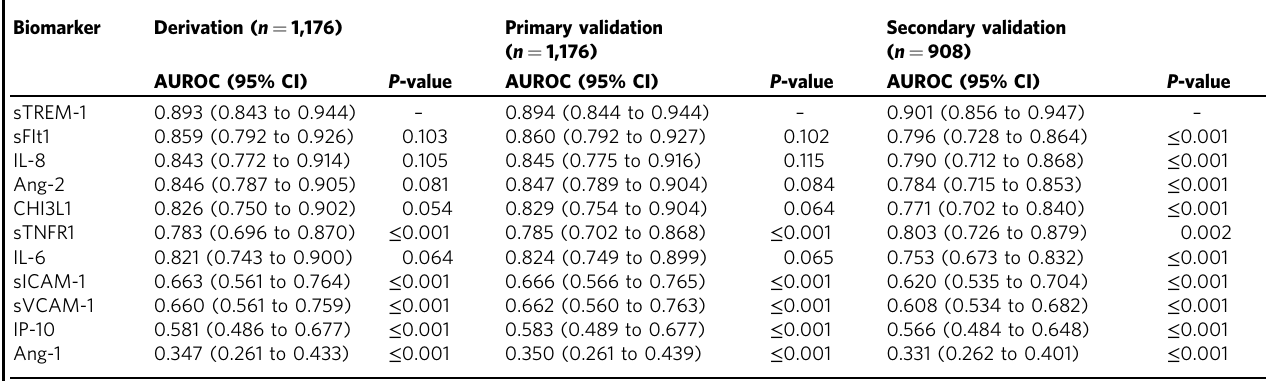
P -values correspond to difference in AUROC as comparedto AUROC of sTREM-1 and were derived from Chi-squared tests. Primary validation was based on 500 bootstrap samples with replacement in the derivation cohort. Secondary validation was performed in the temporally de fi ned validation cohort. AUROC area under the receiver operating characteristic curve, CI con fi dence